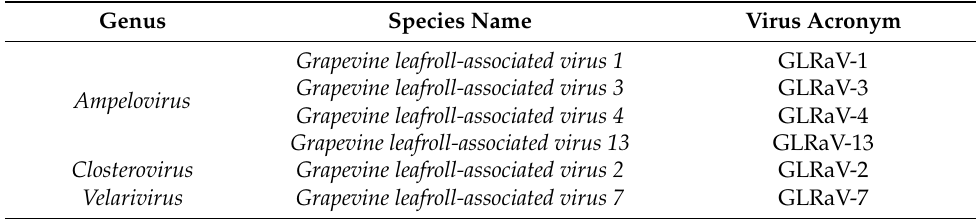
Table 1. Virus species associated with grapevine leafroll disease. Genus Species Name Virus Acronym Grapevine leafroll-associated virus 1 GLRaV-1 Grapevine leafroll-associated virus 3 GLRaV-3 Ampelovirus Grapevine leafroll-associated virus 4 GLRaV-4 Grapevine leafroll-associated virus 13 GLRaV-13 Closterovirus Grapevine leafroll-associated virus 2 GLRaV-2 Velarivirus Grapevine leafroll-associated virus 7